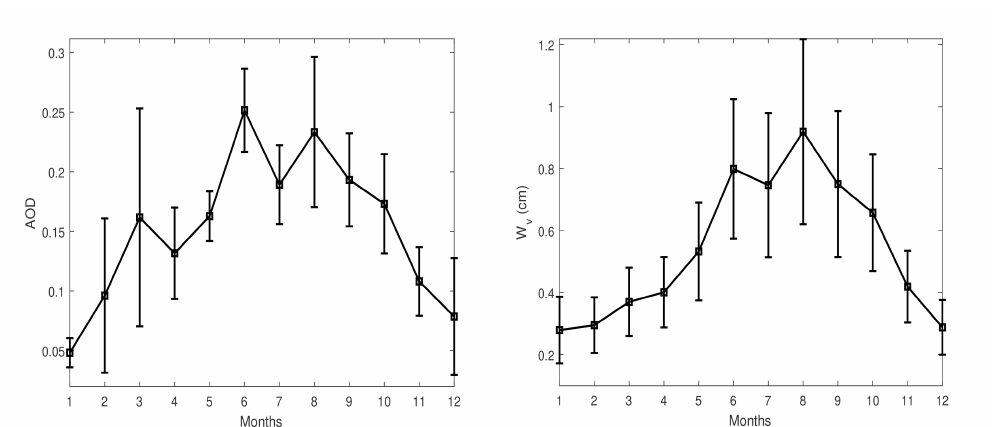
Figure 2. Monthly average of AERONET AOD ( left ) and of MODIS water vapor ( right